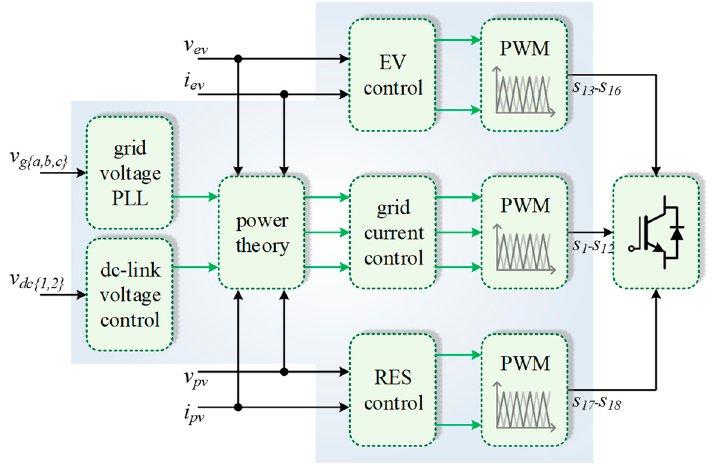
Figure 3. General structure of the control algorithms for the unified topology.